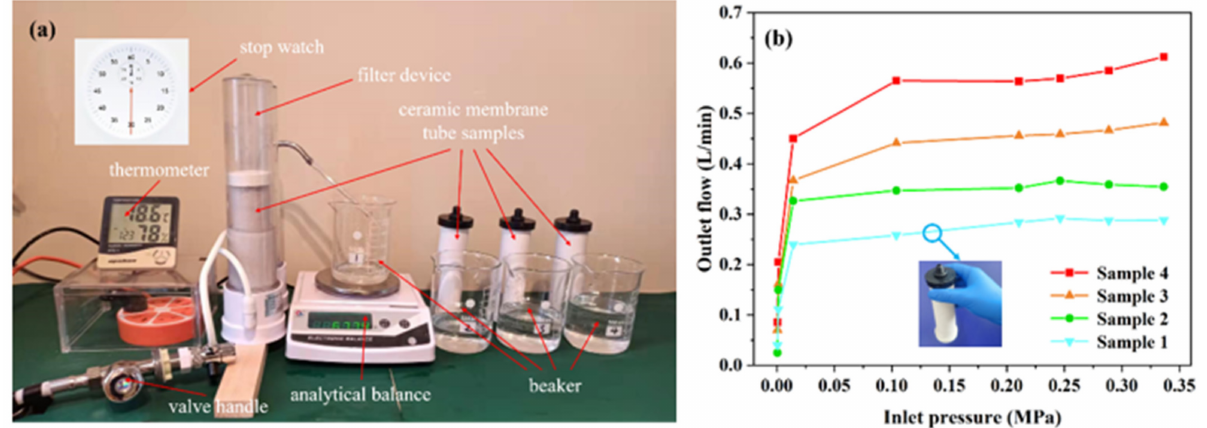
Figure 10. ( a ) Construction of water filtration test system; ( b ) the results of outlet flow for different samples at different inlet